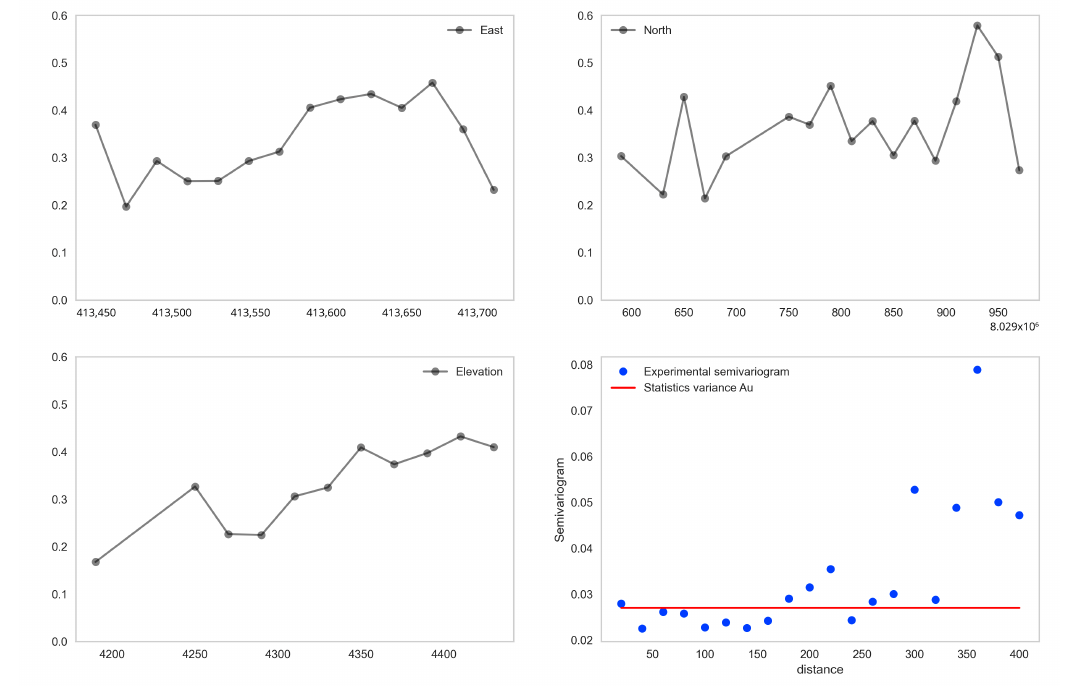
Figure 12. Drift and omnidirectional semivariogram domain D4.